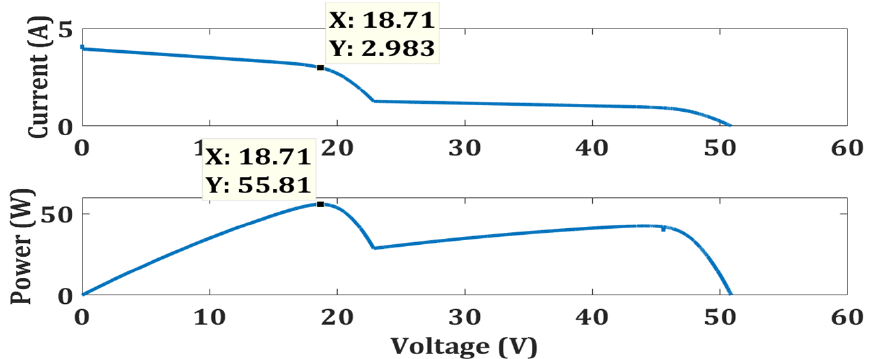
Figure 7. Characteristic curve of 4S PV array under weak partial shading.